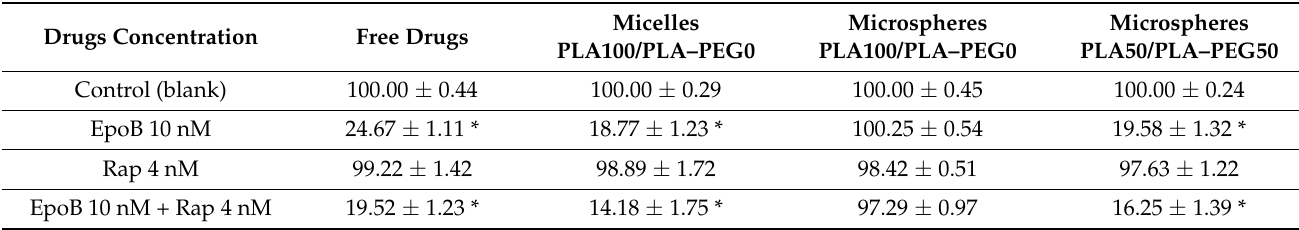
Table 5. Live cell proteins level expressed as a percent of controls (mean values ± standard deviations) in MDA-MB-231 cells after 72 h exposure with free EpoB and Rap, and the drugs-loaded micelles and microspheres measured with sul- forhodamine B assay (TOX-6). Statistically significant differences vs. controls were denoted by asterisks ( p < 0.05). Micelles Drugs Concentration Free Drugs